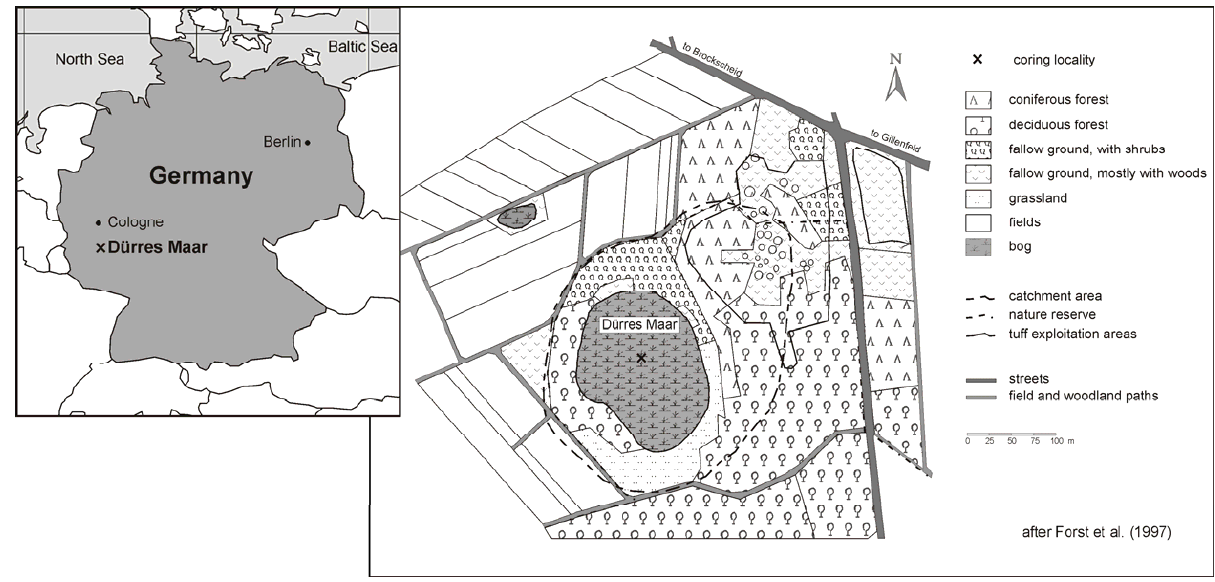
Figure 2: Fig. 1. Location of D¨urres Maar and map of the hosted peat deposit and the surrounding vegetation cover (modified after Forst et al., 1997).